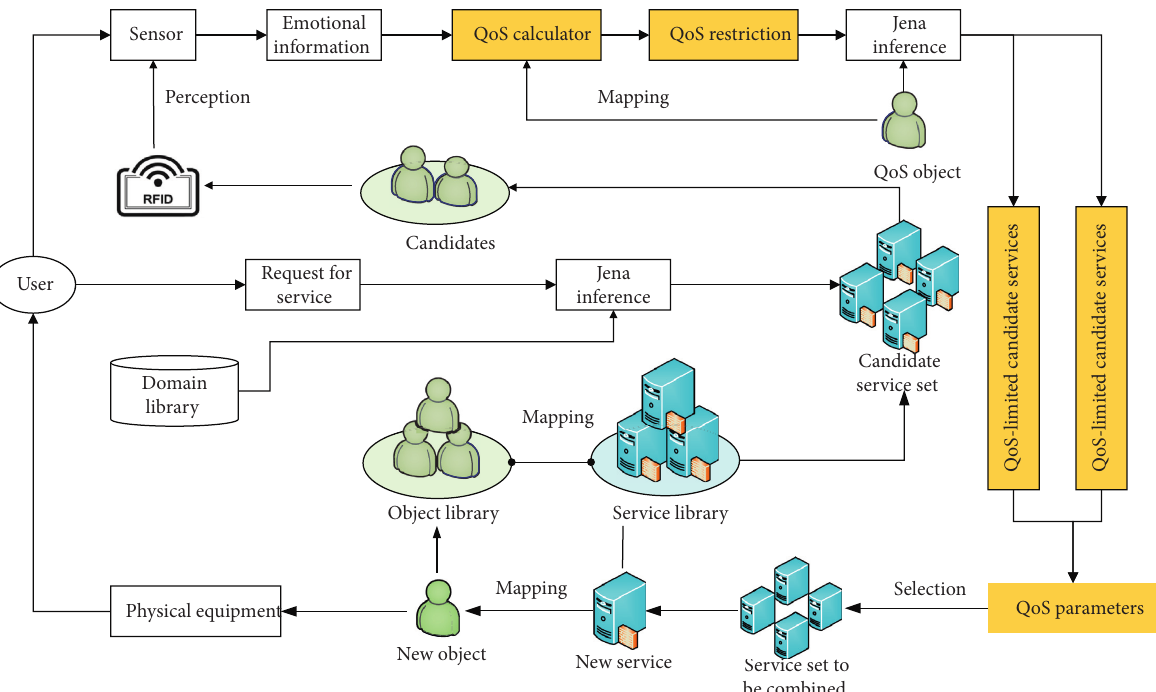
Figure 3: Dynamic composition diagram of IoT services based on